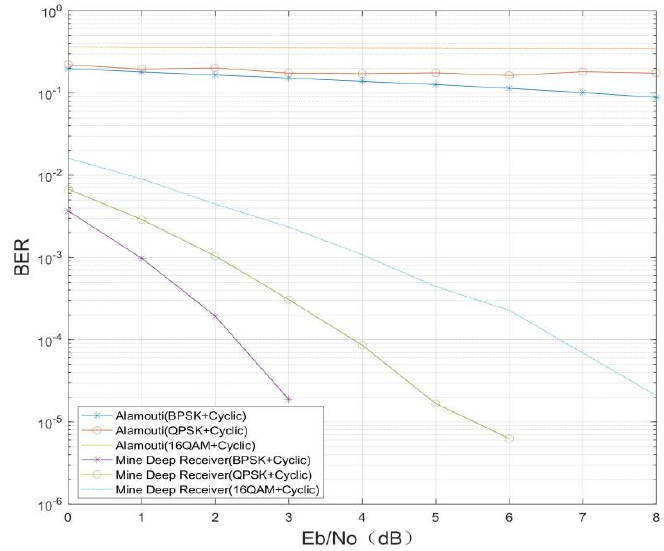
Figure 8. (7, 3) Cyclic channel